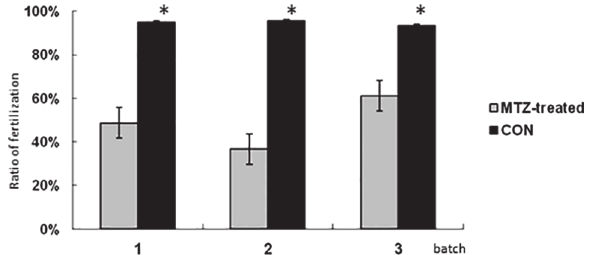
Fig 7. Fertile with impaired fecundity in MTZ-treated transgenic zebrafish males. The fertilization rates of the adult males from 3 independent transgenic lines after MTZ-treatment or DMSO-treatment were recorded. Each group consisted of 10 fishes. The average fertilization rates of the ten fishes of each experiment were measured. The data shown here represents the mean ± the standard error of the mean from three separate